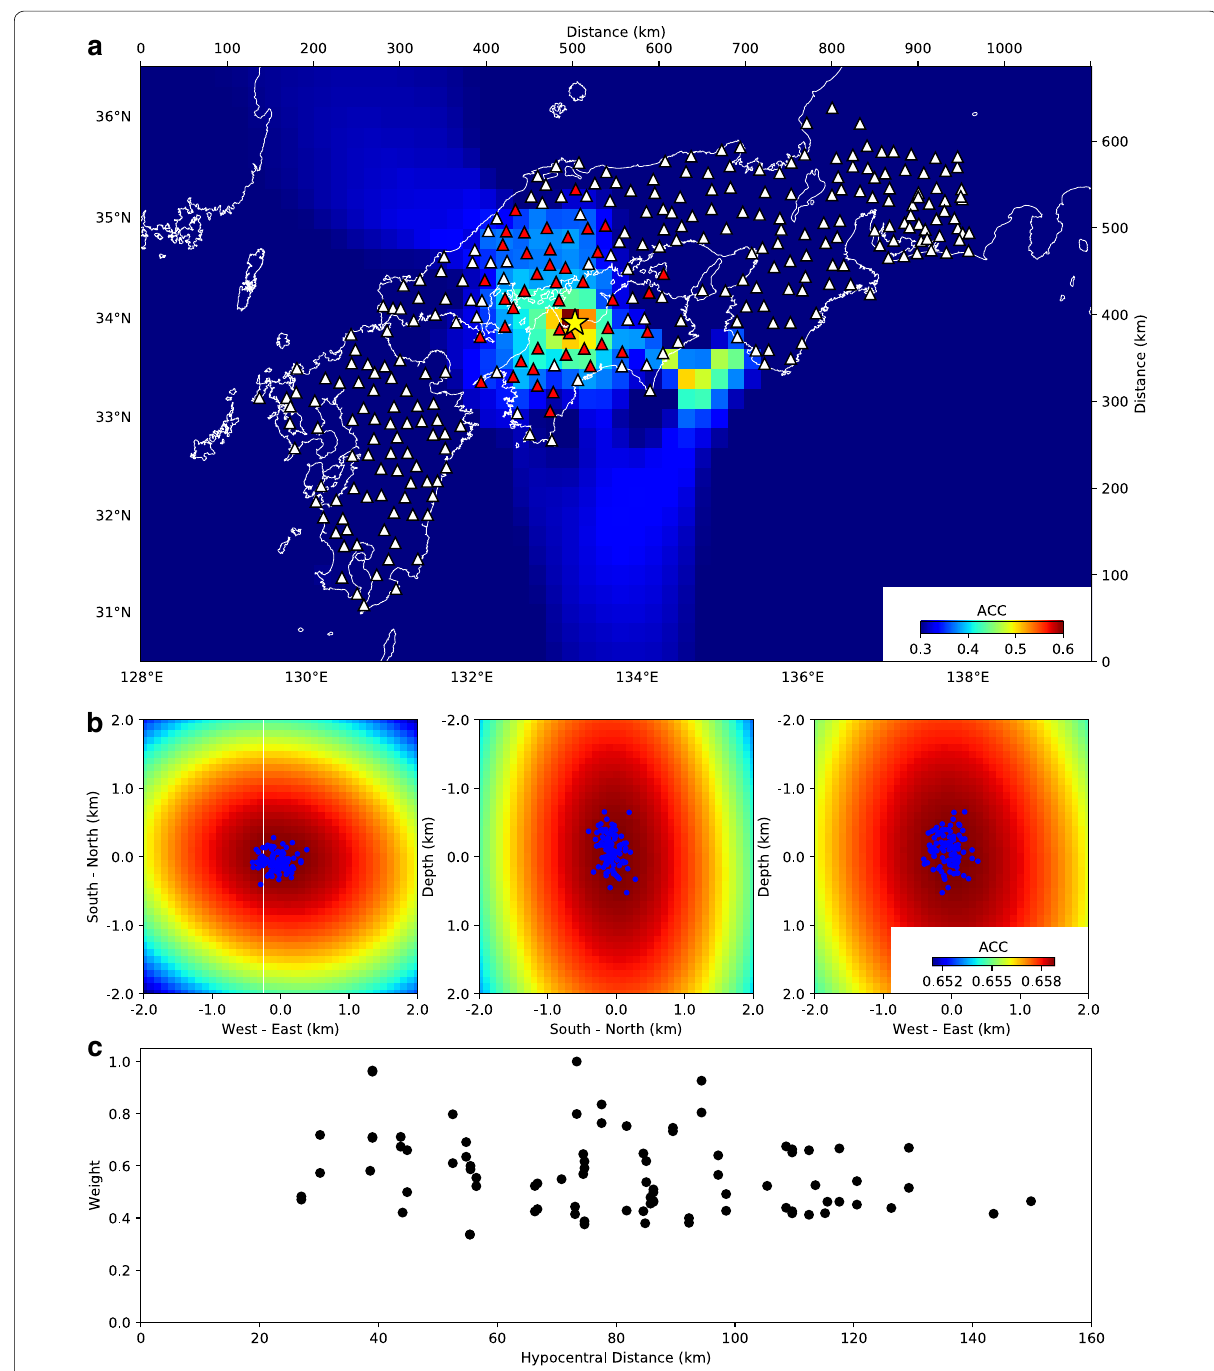
Fig. 2 Single-tremor detection result. a The star shows the final location of the tremor. The tremor occurred at 02:56:05 on May 3, 2010, with a hypocentral location of 33.965°N, 133.252°E, and 23.8 km depth. The heatmap shows the ACC distribution at 30 km depth, determined using the weights calculated as the squares of the hypocentral distances. The red triangles are the seismic stations used in the analysis that met the outlier control criteria. The white triangles mark the seismic stations that were not used in the analysis owing to cross-correlations that did not meet the required threshold. b ACC distribution and bootstrap method result. The axes show the difference from the final tremor location. The heatmaps show the ACC distribution when the tremor source is located at each point. Each blue dot represents the final tremor location for a set of bootstrap samples. c Relationship between the hypocentral distance and the weight which is the inverse of the error variance. The weight is calculated for each component to determine the tremor location and visualized after normalization by the maximum